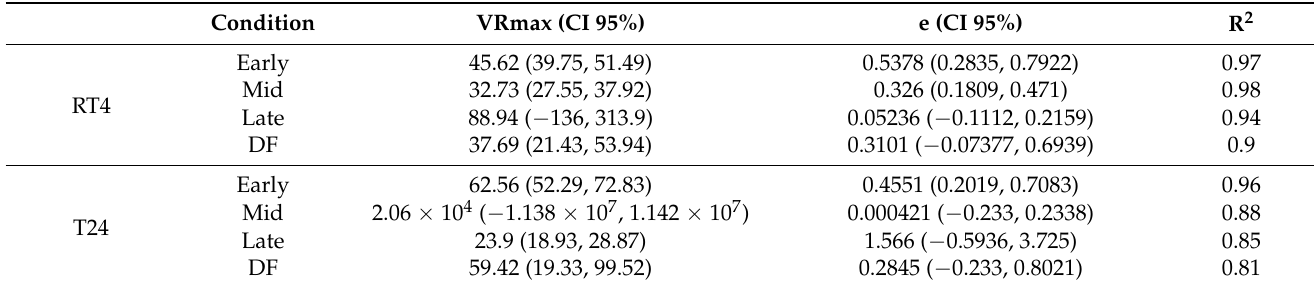
Figure 4. Volume reduction (VR) for RT4 ( A ) and T24 ( B ) human bladder cancer cell lines after performing early, mid and late treatment protocols. Data represents the mean of at least three independent experiments ± SEM. Data are fitted to a curvilinear model (Equation (7)). Fitting parameters and the corresponding R 2 values are shown in Table 4. Sphere images are shown in Figures S1–S3. A (RT4) and B (T24) show the VR (%) as a function of irradiation dose (Gy) in the early, mid and late protocols for all three cell lines. Table 4. Fitting parameters of VR(D). Data were fitted to a curvilinear model (VR ( D ) = VR max ( 1 − exp ( − eD ))